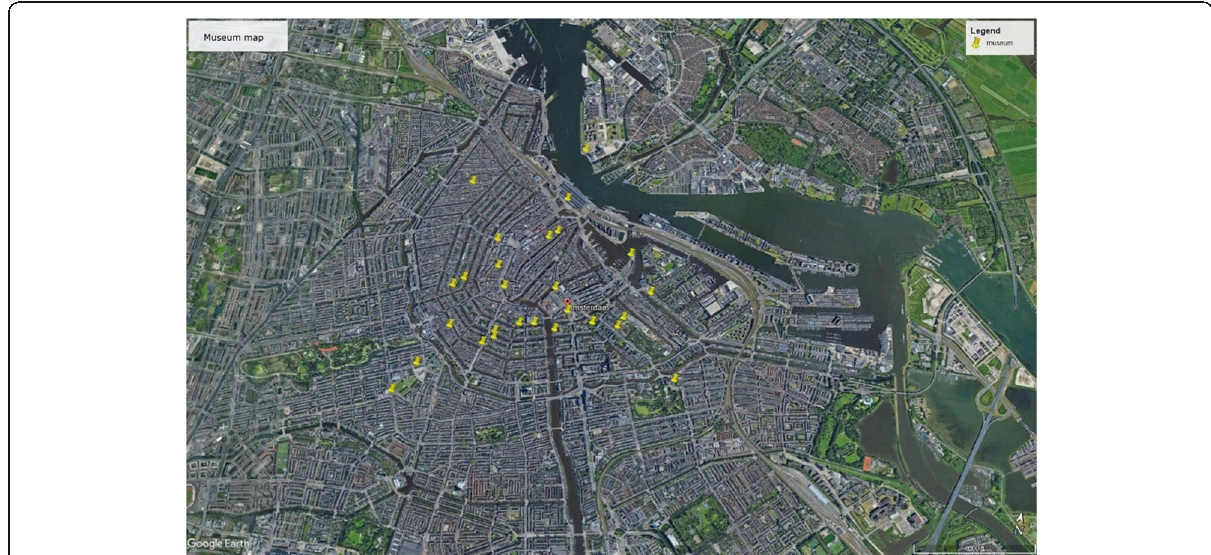
Fig. 2 The museums and canals in Amsterdam. @google